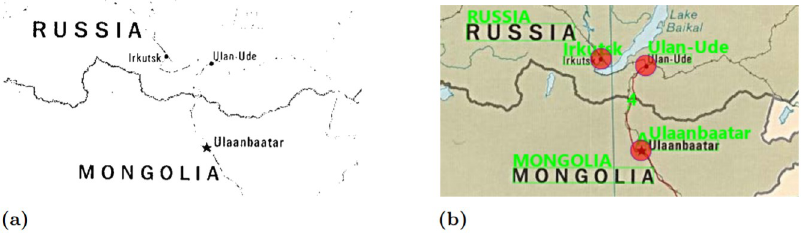
Fig 2. Illustration of toponym recognition. (a) Thresholded image using the 4 E metric for the automated identification of text and toponym markers. (b) Identified map text labels (in green) and toponym marker points (in red). The map image is from the University of Texas at Austin’s Perry-Casta ñ eda Library (PCL) Map Collection and is in the public domain: https://maps.lib.utexas.edu/maps/middle_east_and_asia/china_pol96.jpg.